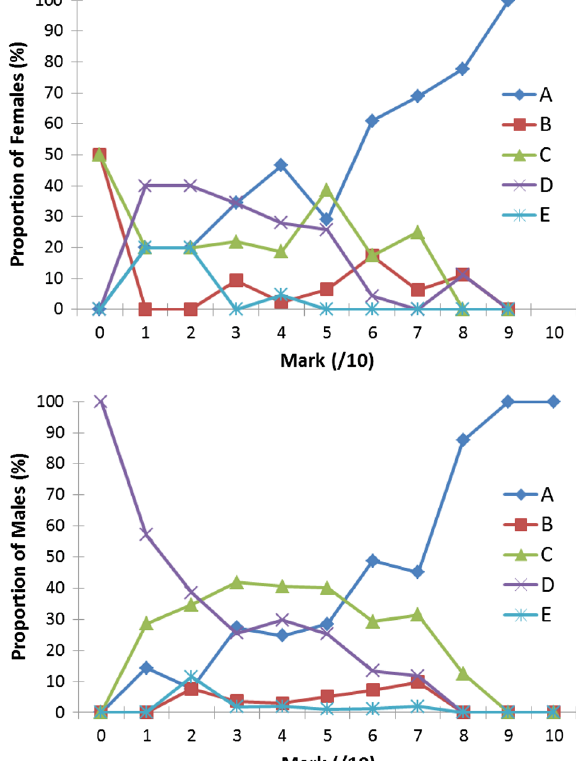
FIG. 9. Female (top) and male (bottom) answer choices for question 2 of the 2010 ASOE, collision of two objects with same kinetic energy . The colors or shading within each horizontal bar indicate the choices made by those students on the previous question (2010 Q1, kinetic of two objects ). The correct choice pair is Q1-B (red or striped upwards) and Q2-A (lowest horizontal